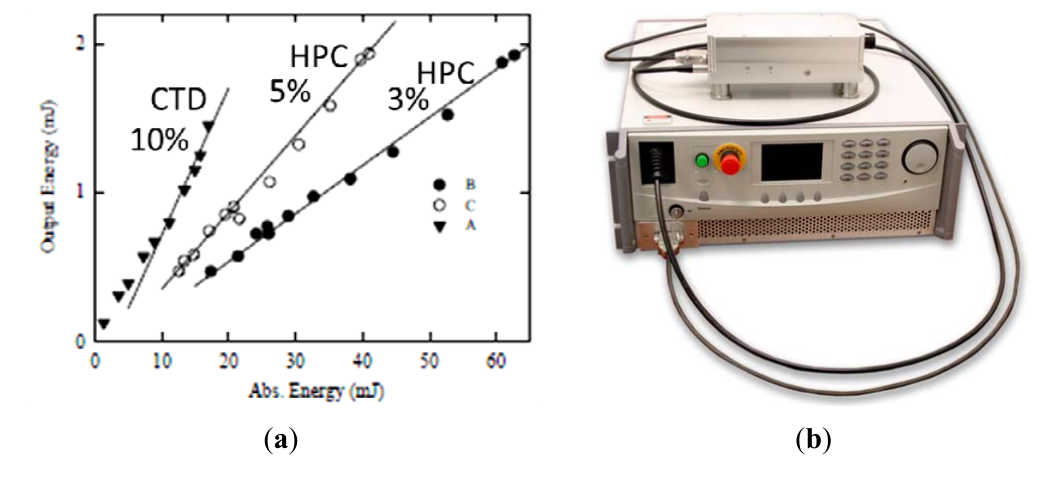
Figure 12. ( a ) The laser results for ceramic Cr 2+ :ZnSe made by hot pressing ceramics (HPC) and by chemical diffusion of CrSe into CVD ZnSe (CTD) (after [28]); and ( b ) a 15 W commercial source available from IPG [29].